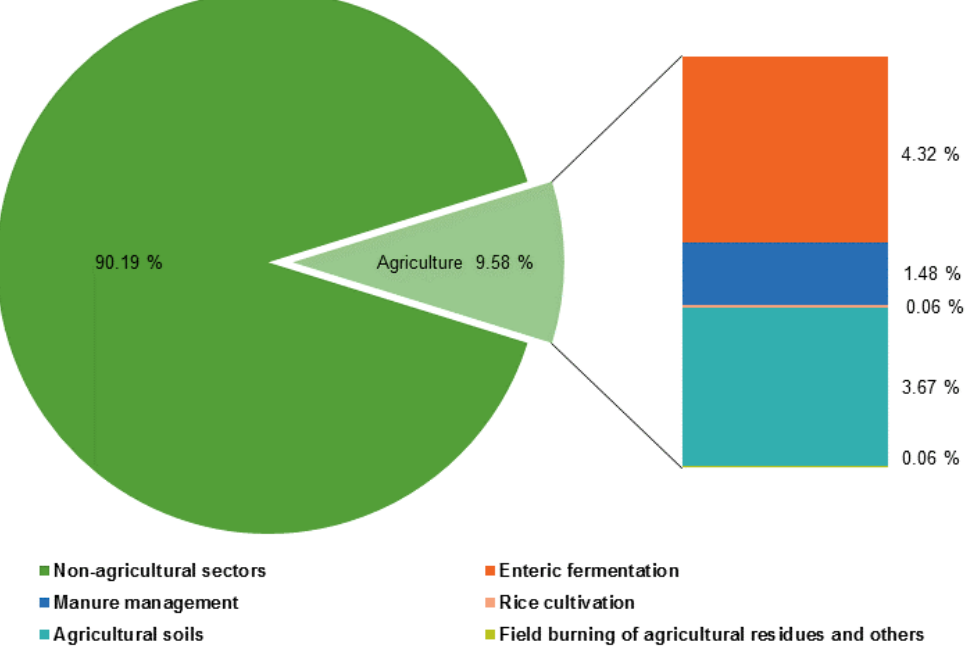
Figure 1. Contribution of agriculture to total GHG emissions (%), EU-28, 2015 [7].